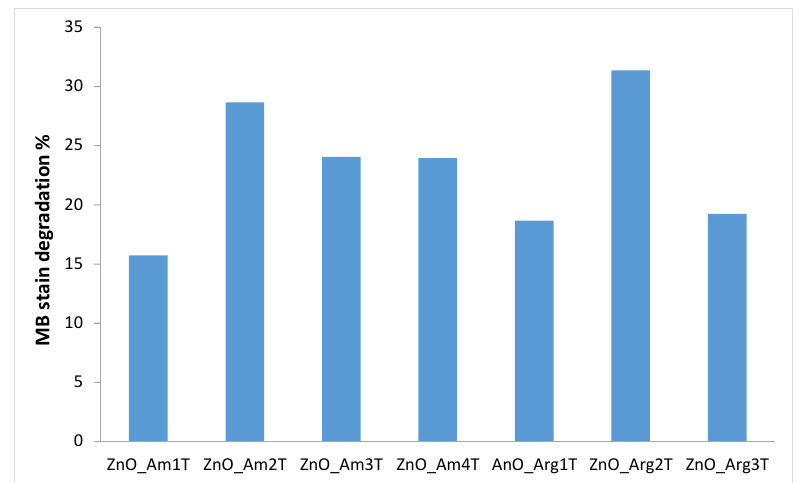
Figure 10. Discoloration of MB stains on the cotton samples functionalized with ZnO NPs obtained under various conditions.